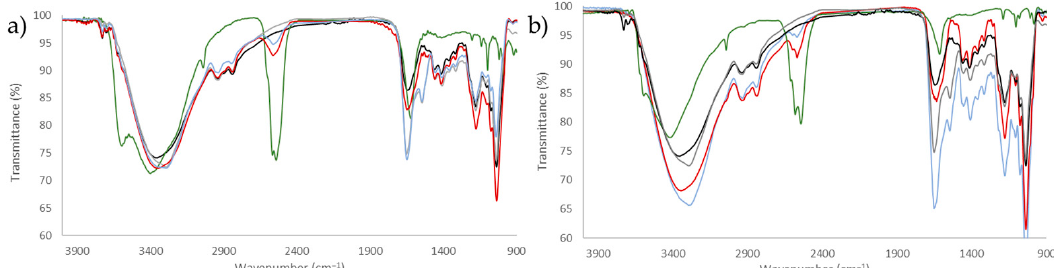
Figure 4. ( a ) IR spectra of 2 mM of Na[ o ‐ COSAN] in aqueous solution (green), in DMEM culture medium solution (red), in DMEM + 10% FBS solution (blue), DMEM culture medium solution (black), and DMEM + 10% FBS solution (grey). ( b ) IR spectra of 2 mM of Na[8,8 ′‐ I 2 ‐ o ‐ COSAN] in aqueous solution (green), 2 mM of Na[ o ‐ COSAN] in DMEM culture medium solution (red), 2 mM of Na[8,8 ′‐ I 2 ‐ o ‐ COSAN] in DMEM + 10% FBS solution (blue), DMEM culture medium solution (black), and DMEM + 10% FBS solution (grey).